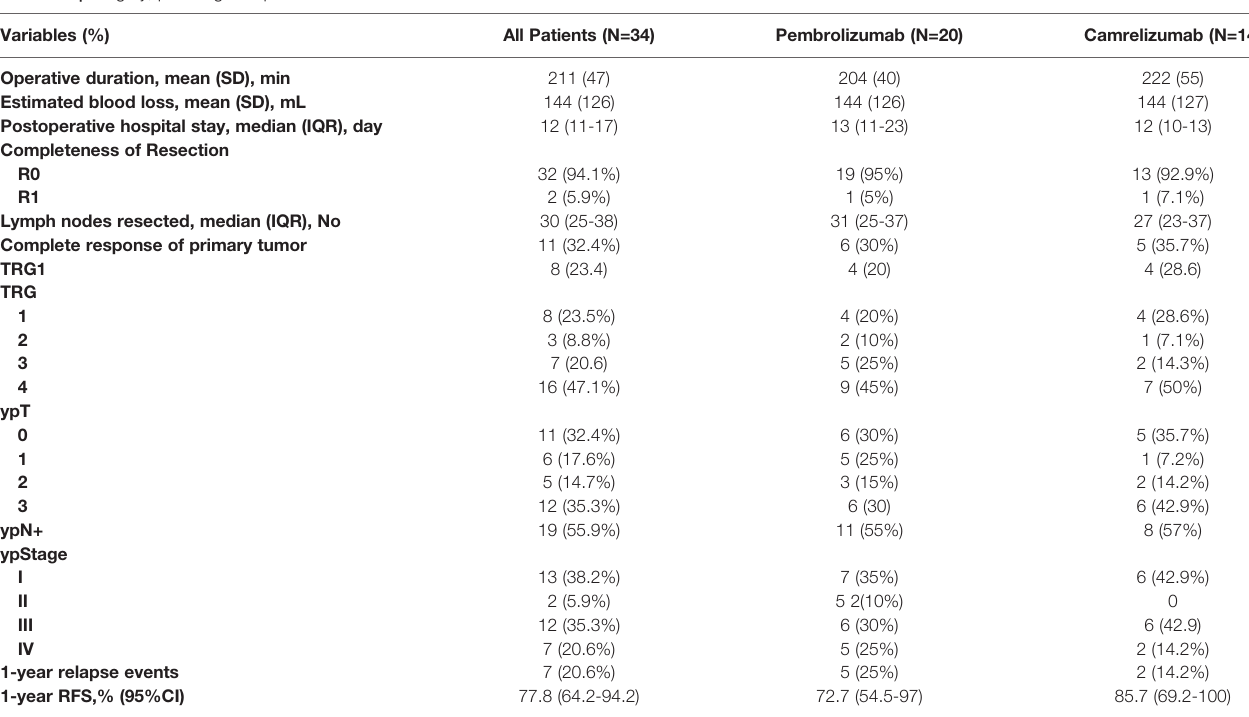
TABLE 3 | Surgery, pathologic response and survival outcomes. Variables